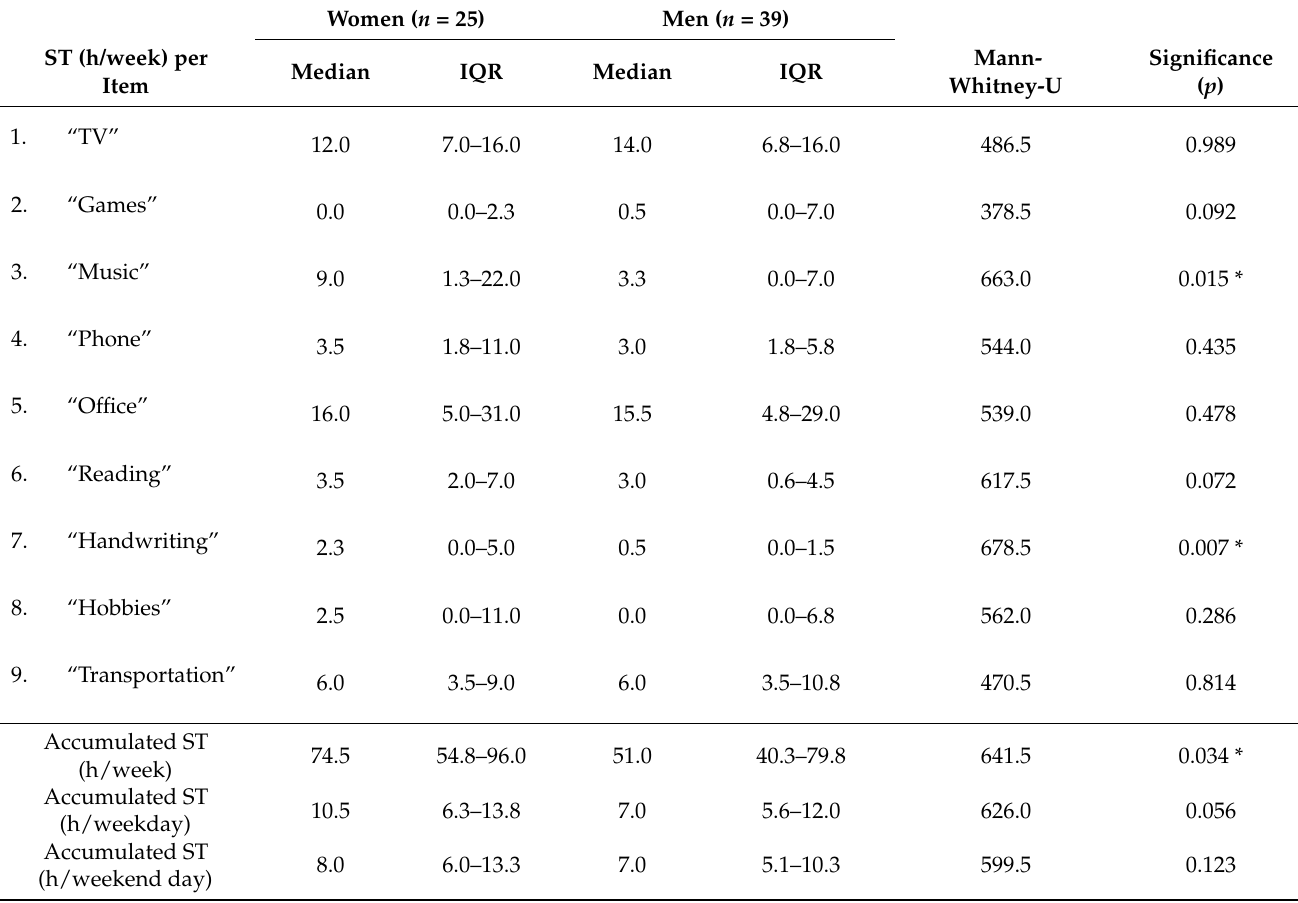
Table 2. Gender-specific differences in mSBQ items and summary